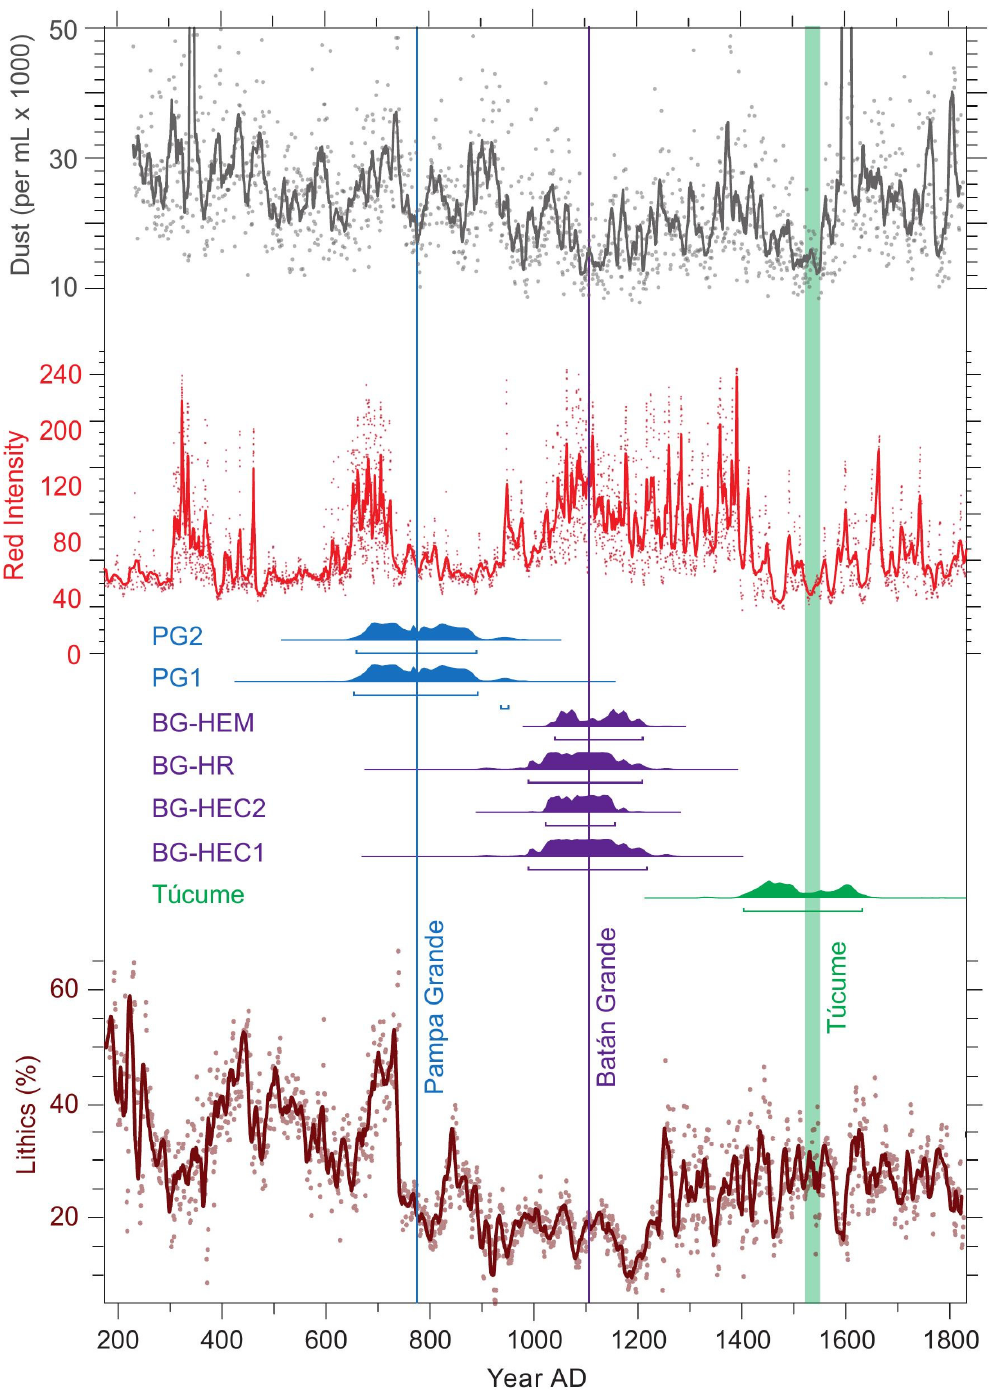
Figure 3. Dates of abandonment at Pampa Grande (blue) (from [1]), Batan Grande (purple) (from [2]), and T ú cume (green) (from [3]). Brackets indicate confidence limits (95.4%) on dates. Dates for Pampa Grande and Batan Grande are on contexts closely associated with the burning and abandonment. The vertical blue and purple lines represent the average median date for these sites’ abandonments. The date for T ú cume is for the 60-year Inca period immediately preceding abandonment; the green bar represents the known historic age of abandonment as a result of the Spanish Conquest (1532-1547 AD). The dates were calibrated using OxCal 4.4 [22] with the SHCal20 curve [23]. El Niño proxy records based on: Quelccaya dust record [6] (gray), red intensity of lake sediments from Pallcacocha [7,25] (red), and lithic concentrations in marine core 106KL [4,5] (brown).